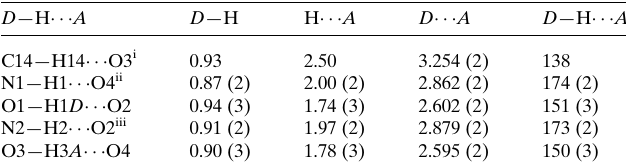
Table 1 Hydrogen-bond geometry (A˚ , (cid:3) ).